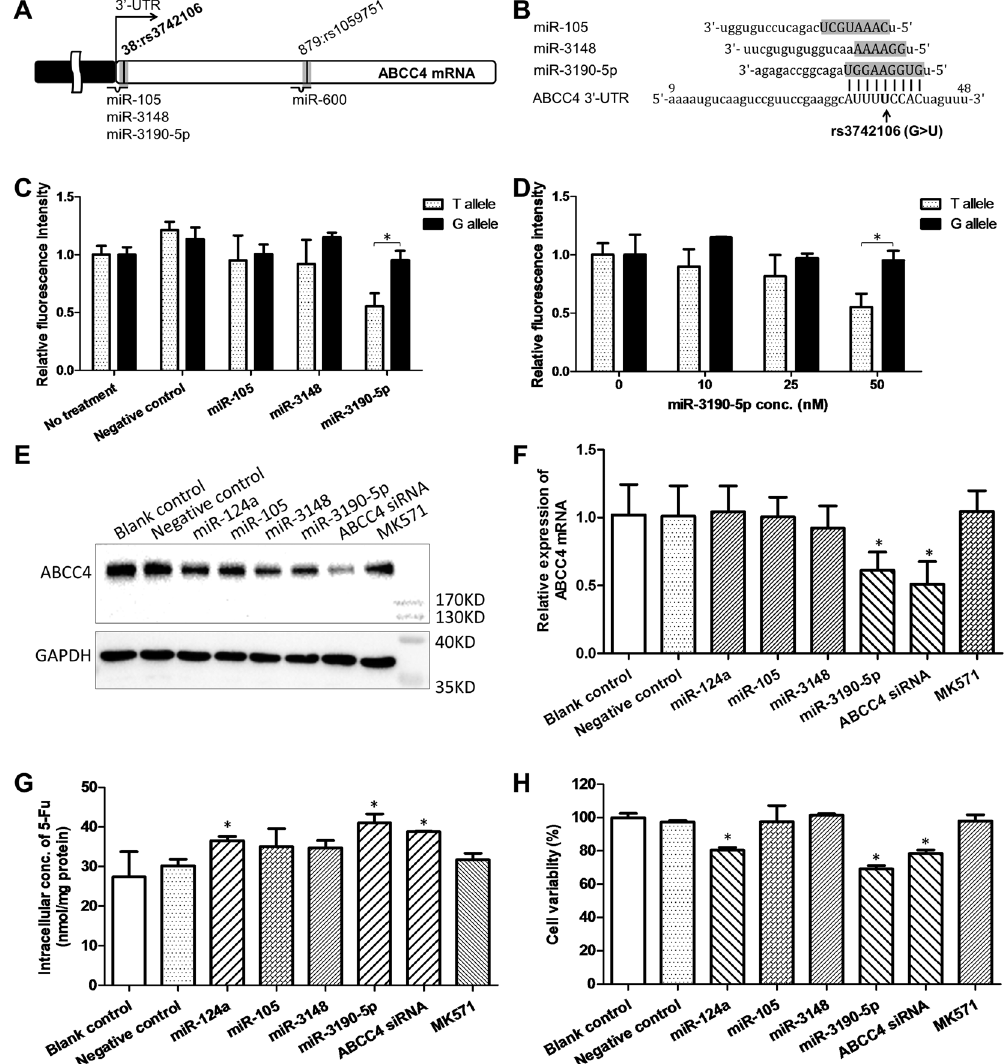
Figure 1. The effect of miR-3190-5p on the expression of ABCC4, transmembrane transportation of 5-FU, and proliferation of HCT-116 cells. ( A ) The polymorphisms in the predicted binding-sites of miRNAs in the 3 ′ -UTR of ABCC4 gene. ( B ) The rs3742106 locates in the ‘seed-region’ of miR-105, miR-3148, and miR- 3190-5p. The uppercase letters indicated the binding-sites for miRNAs. ( C ) Luciferase reporter analysis of the impact of miRNAs on the expression of the T- and G-allelic ABCC4/3 ′ -UTR/pGL3 constructs. ( D ) Luciferase reporter analysis of the impact of miR-3190-5p on the expression of the T- and G-allelic ABCC4/3 ′ -UTR/pGL3 constructs. ( E ) The effect of miR-124a, miR-105, miR-3148, miR-3190-5p, ABCC4 siRNA, and MK571 on the expression of ABCC4 protein in HCT-116 cells. The full-length blots are presented in Supplementary Fig. 4. ( F ) The effect of miR-124a, miR-105, miR-3148, miR-3190-5p, ABCC4 siRNA, and MK571 on the expression of ABCC4 mRNA in HCT-116 cells. ( G ) The effect of miR-124a, miR-105, miR-3148, miR-3190-5p, ABCC4 siRNA, and MK571 on the intracellular concentration of 5-FU in HCT-116 cells. In Figures E–G, the cells were treated with the regulators for 72 h before the addition of 5-FU. ( H ) The effect of miR-124a, miR-105, miR- 3148, miR-3190-5p, ABCC4 siRNA, and MK571 on the growth of HCT-116 cells co-treated with 5-FU. Each experiment was repeated for three times; the data were presented in the histograms as mean with SD, and were statistically analyzed by using t -test as compared with the negative control; * P <